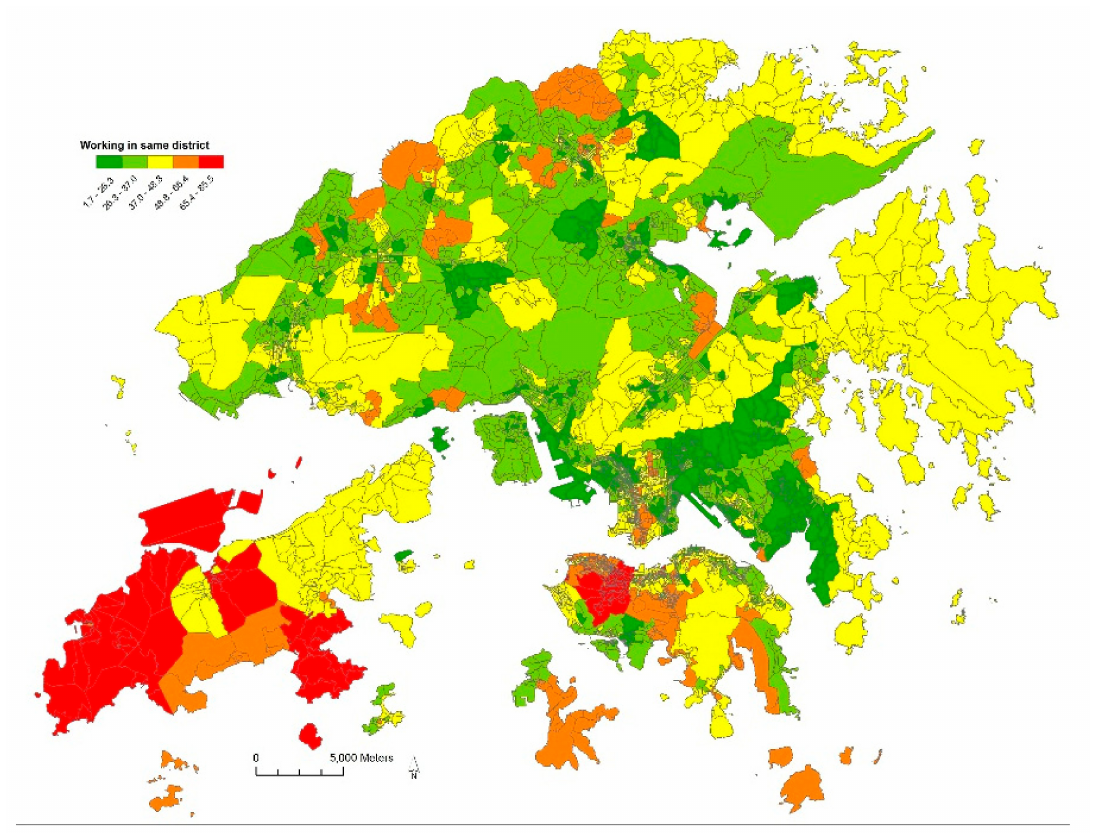
Figure 2. Percentage of residents working in the same district as their residence.